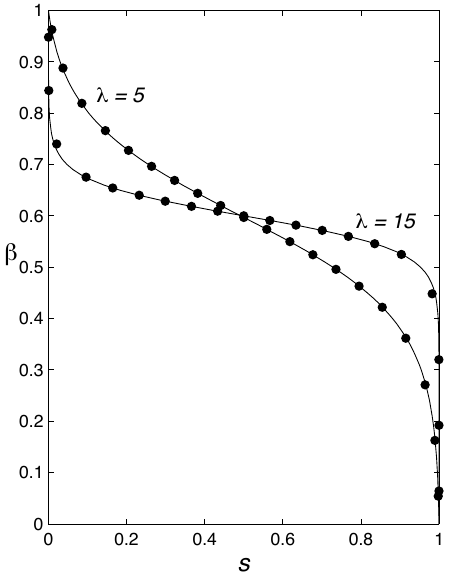
Fig. 1. s(β) profile from Eq. (27) for z 0 = 0 . 6 and λ = 5 and 15. The solid circles indicate the values of s at the layer mid-points for M =